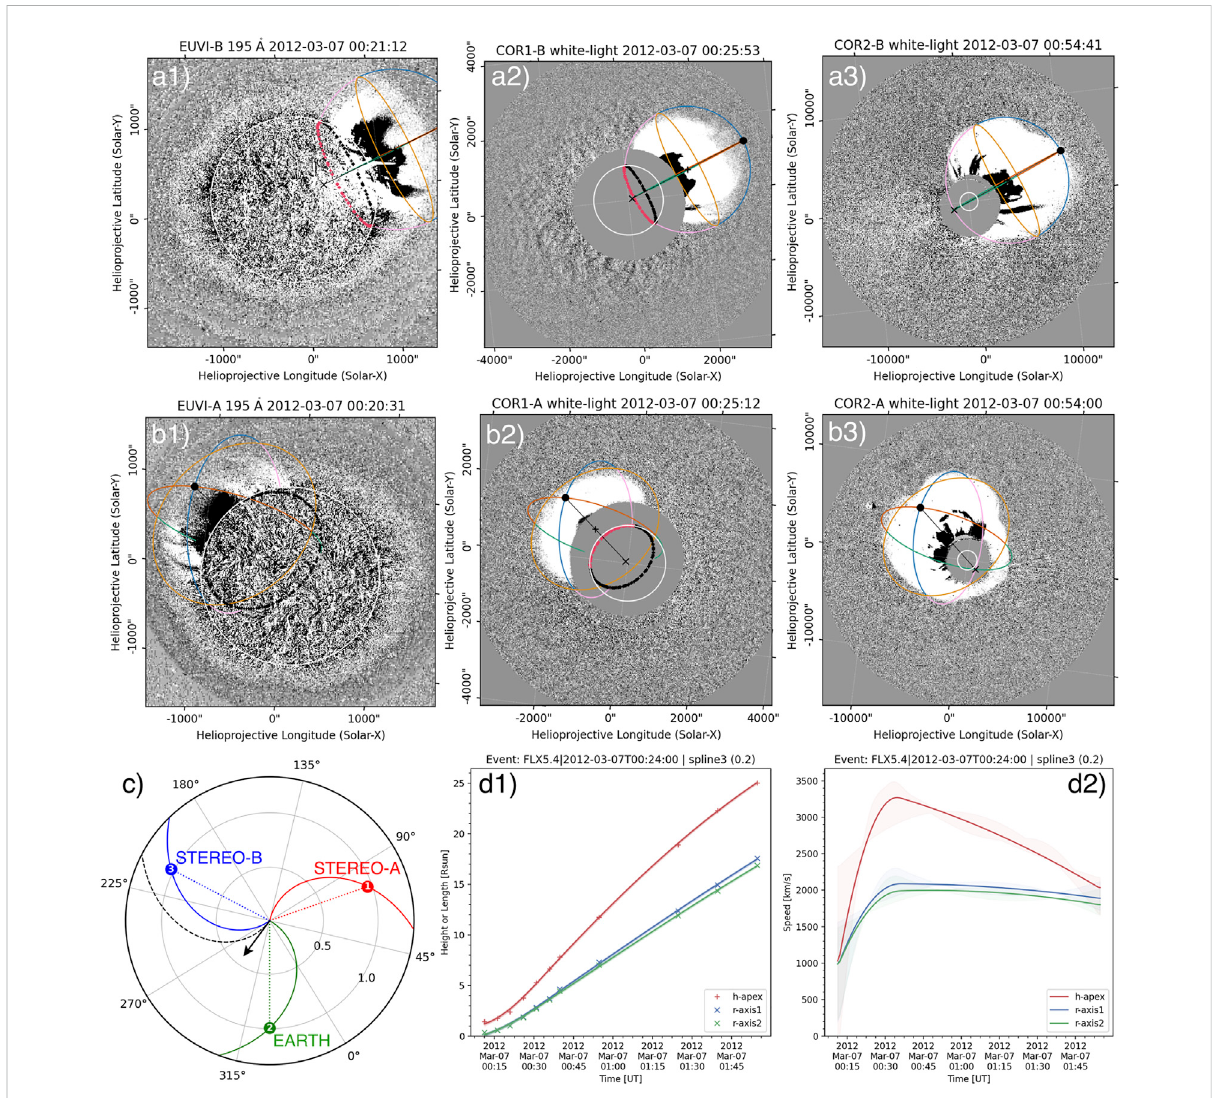
FIGURE 8 Selectedresultsfromtheshockreconstructionofthe7March2012solarevent.Panels (A1 – A3) ,showimagesfromSTEREO-AEUVI,COR1,and COR2 where we also show the reconstructed shock wave front. Similar to panels (B1 – B3) that show nearly simultaneous images from STEREO-B. Panel (C) isaview oftheeclipticplane fromtheecliptic northshowingtherelativepositionsoftheSTEREO-A/BandEarthinCarringtoncoordinates, on 7 March 2012 at 00:15 UT. This ecliptic view is produced with the Solar-MACH tool. Panels (D1, D2) , show the height and kinematic time pro fi le plots, respectively, of the reconstructed shock